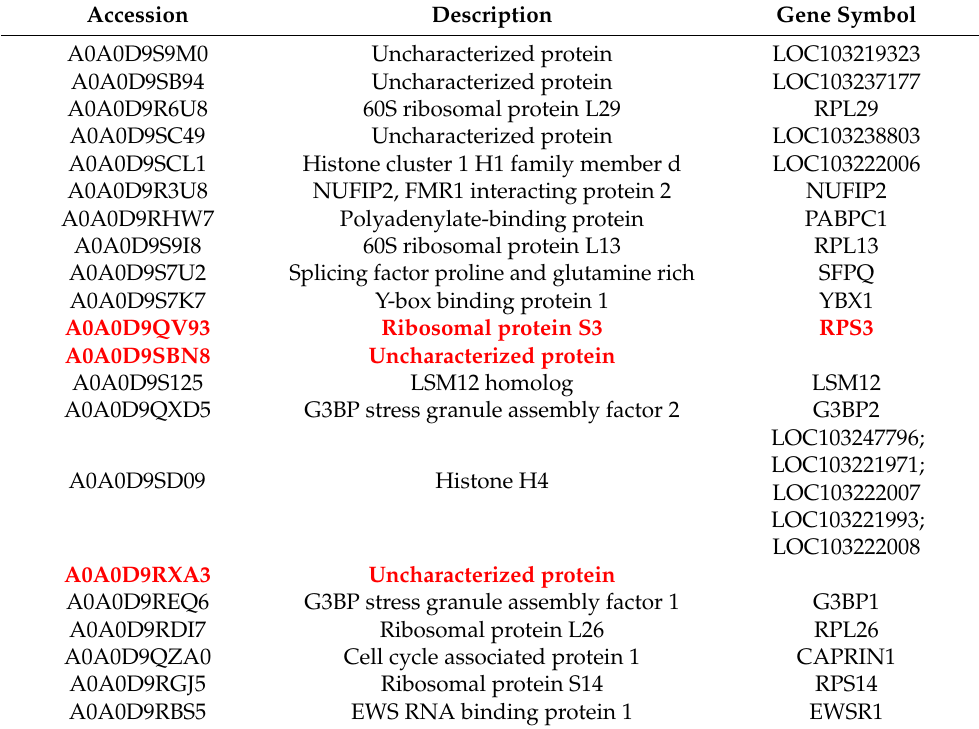
Table 2. Brief result of mass